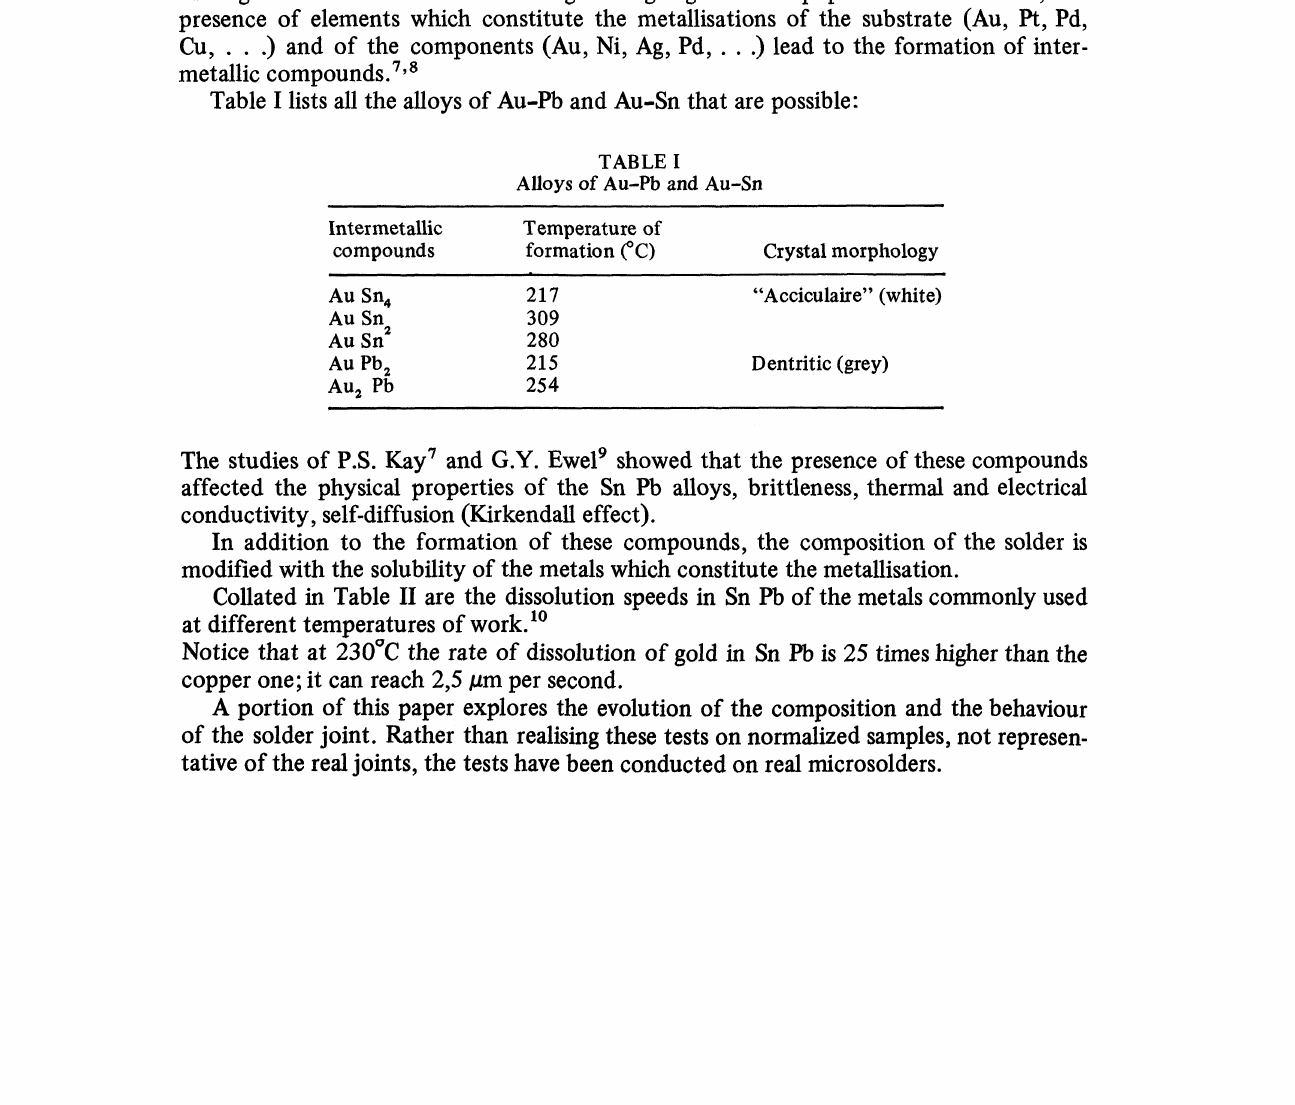
TABLE Alloys of Au-Pb and